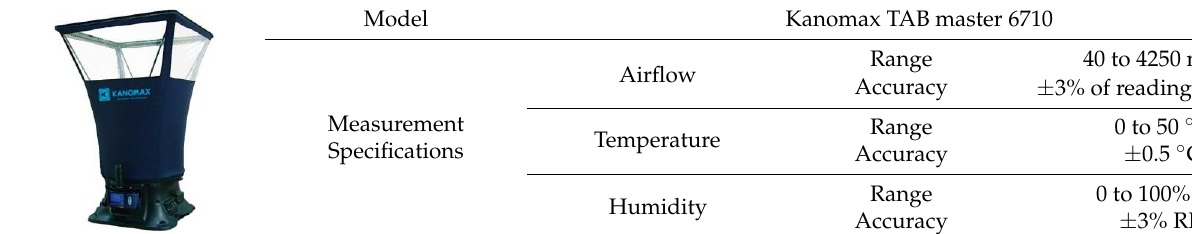
Table 5. Airflow sensor specification.